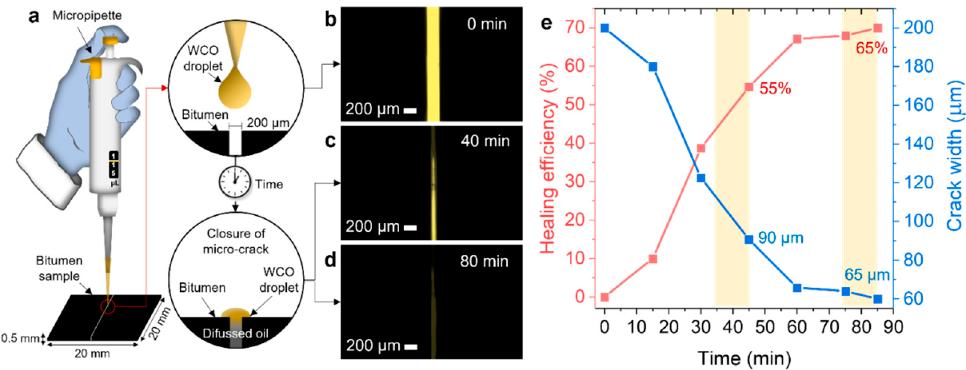
Figure 6. ( a ) Experimental set-up to evaluate the crack-healing of WCO on a long-term aged bitumen sample; ( b–d ) Fluorescence microscopy images showing the microcrack closure over time using WCO as healing agent; ( e ) Results of healing efficiency and crack width measured on the long-term aged bitumen sample.